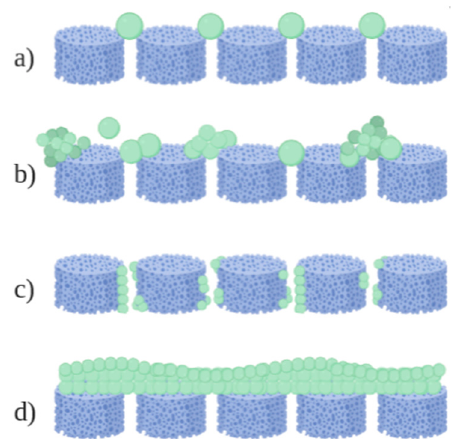
Figure 1. Graphical representation of the fouling mechanisms: ( a ) complete pore blocking, ( b ) partial pore blocking, ( c ) internal pore blocking and ( d ) cake formation [12].